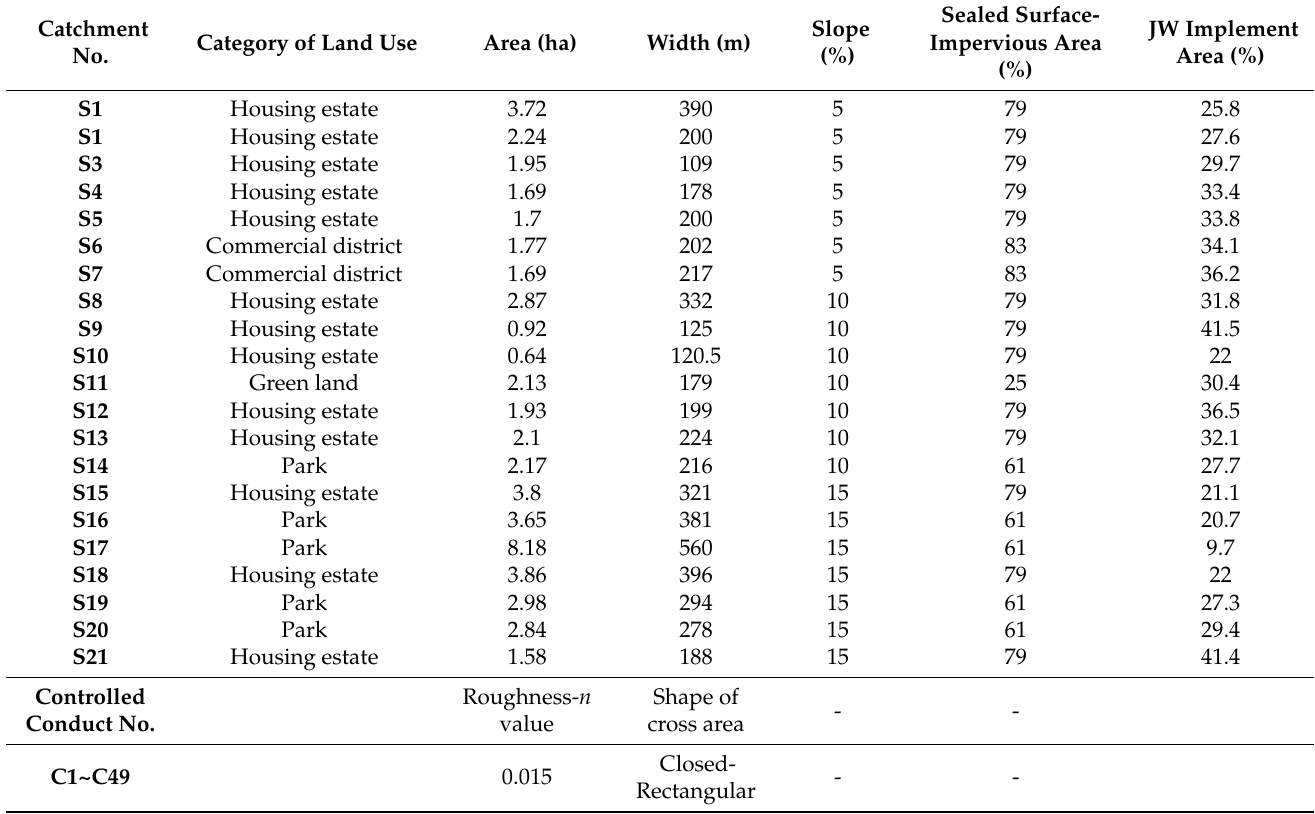
Table A1. Overview of stormwater management model (SWMM) sub-catchments parameters (refer to Figure 3).